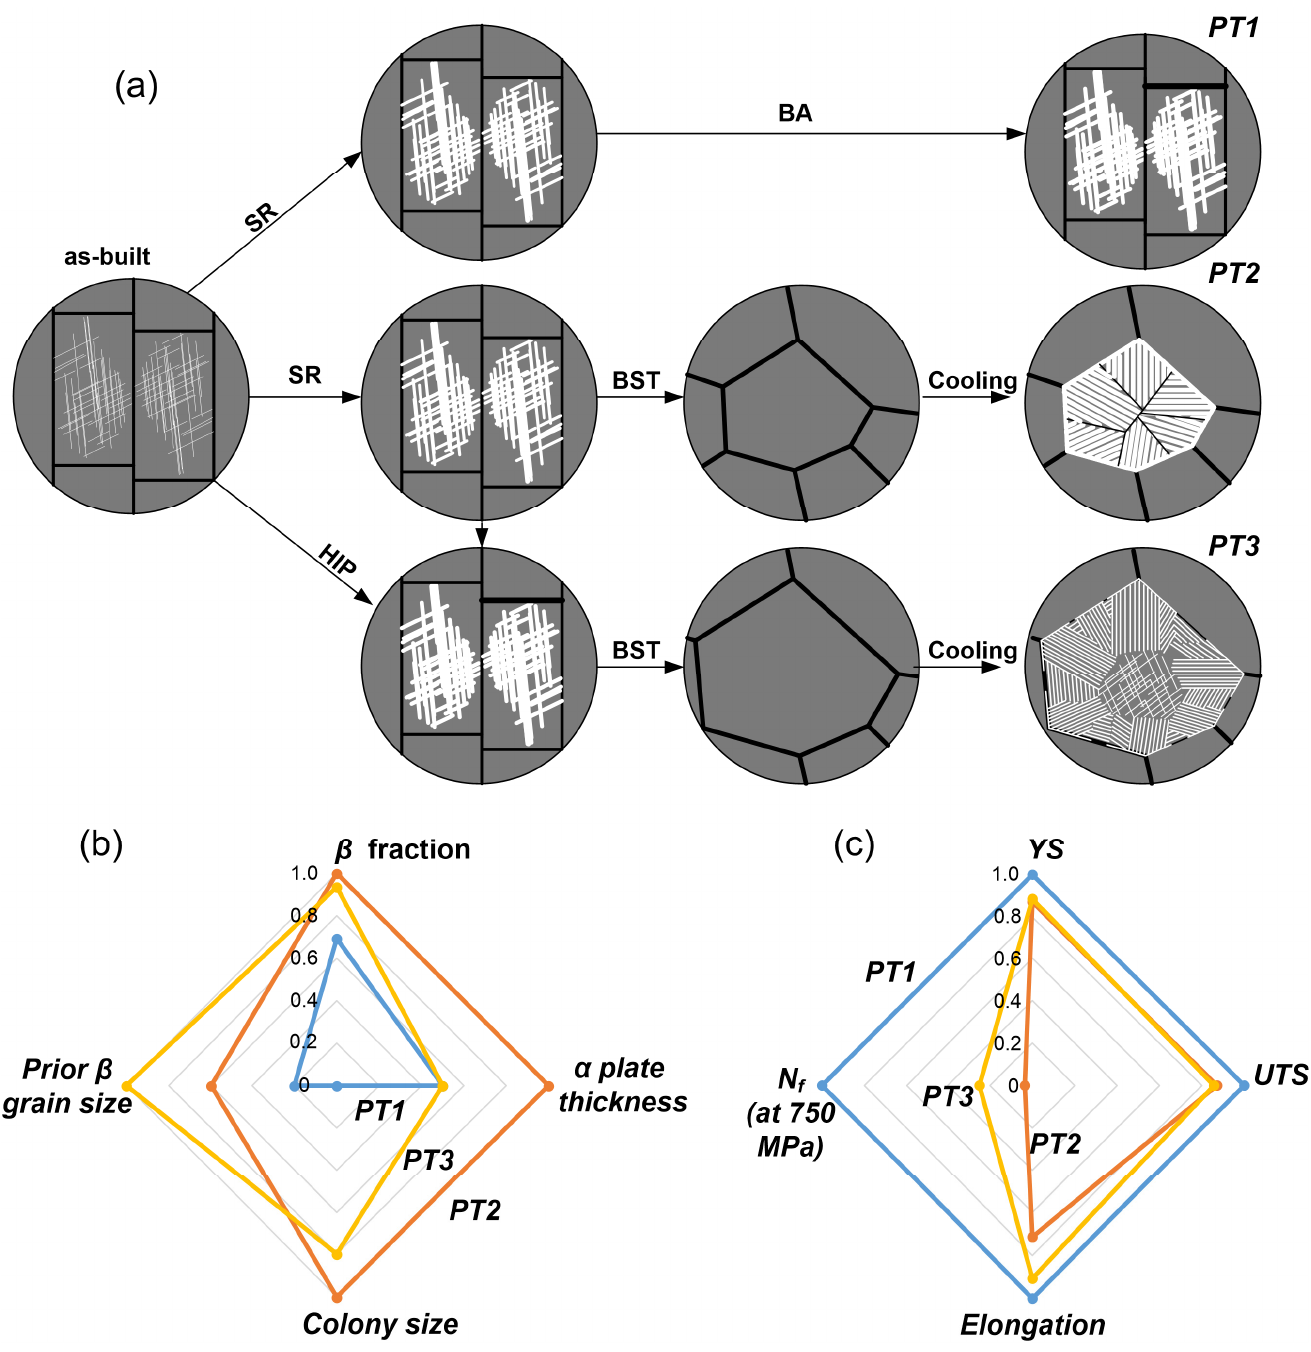
Figure 14. ( a ) Schematic presentation (inspired by [36]) of the microstructure changes during the PTs treatments, ( b ) microstructure characteristics and ( c ) mechanical properties. treatments, ( b ) microstructure characteristics and ( c ) mechanical